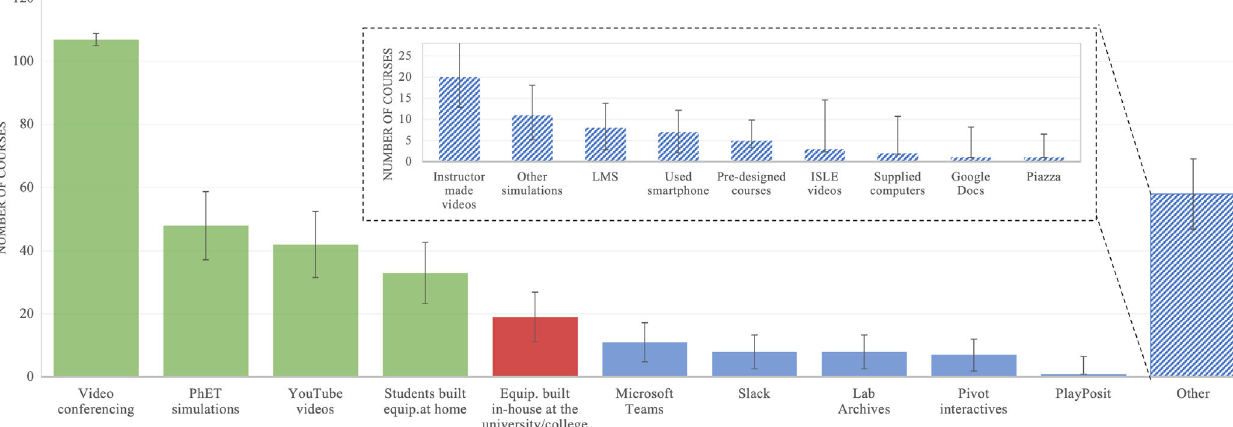
FIG. 9. Instructor reported equipment and technology used after the transition to remote instruction in Spring